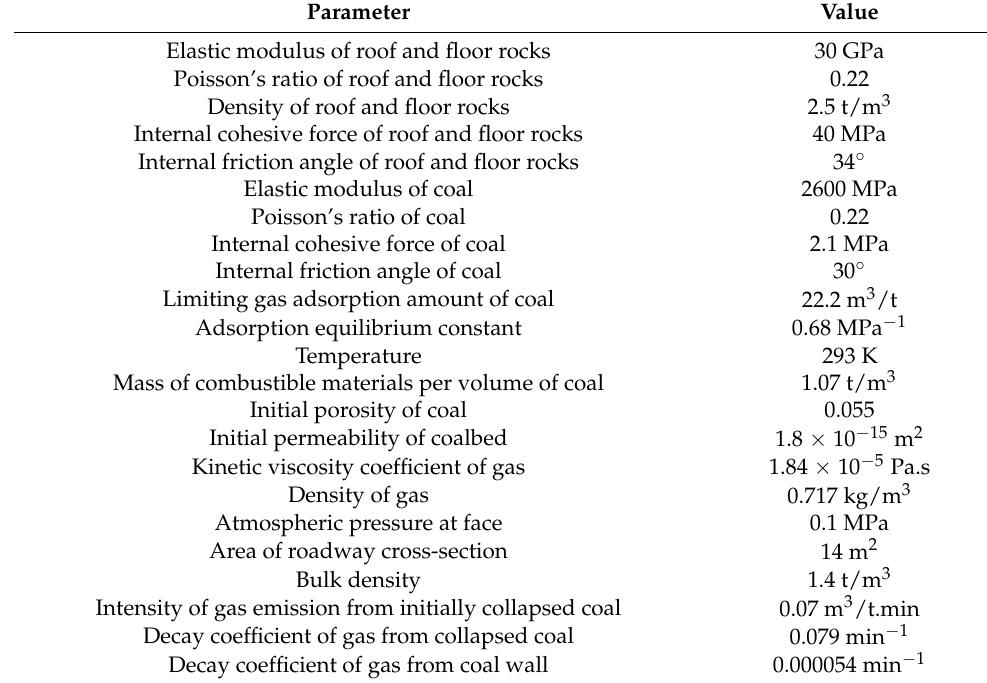
Table 1. Basic parameters of the model.